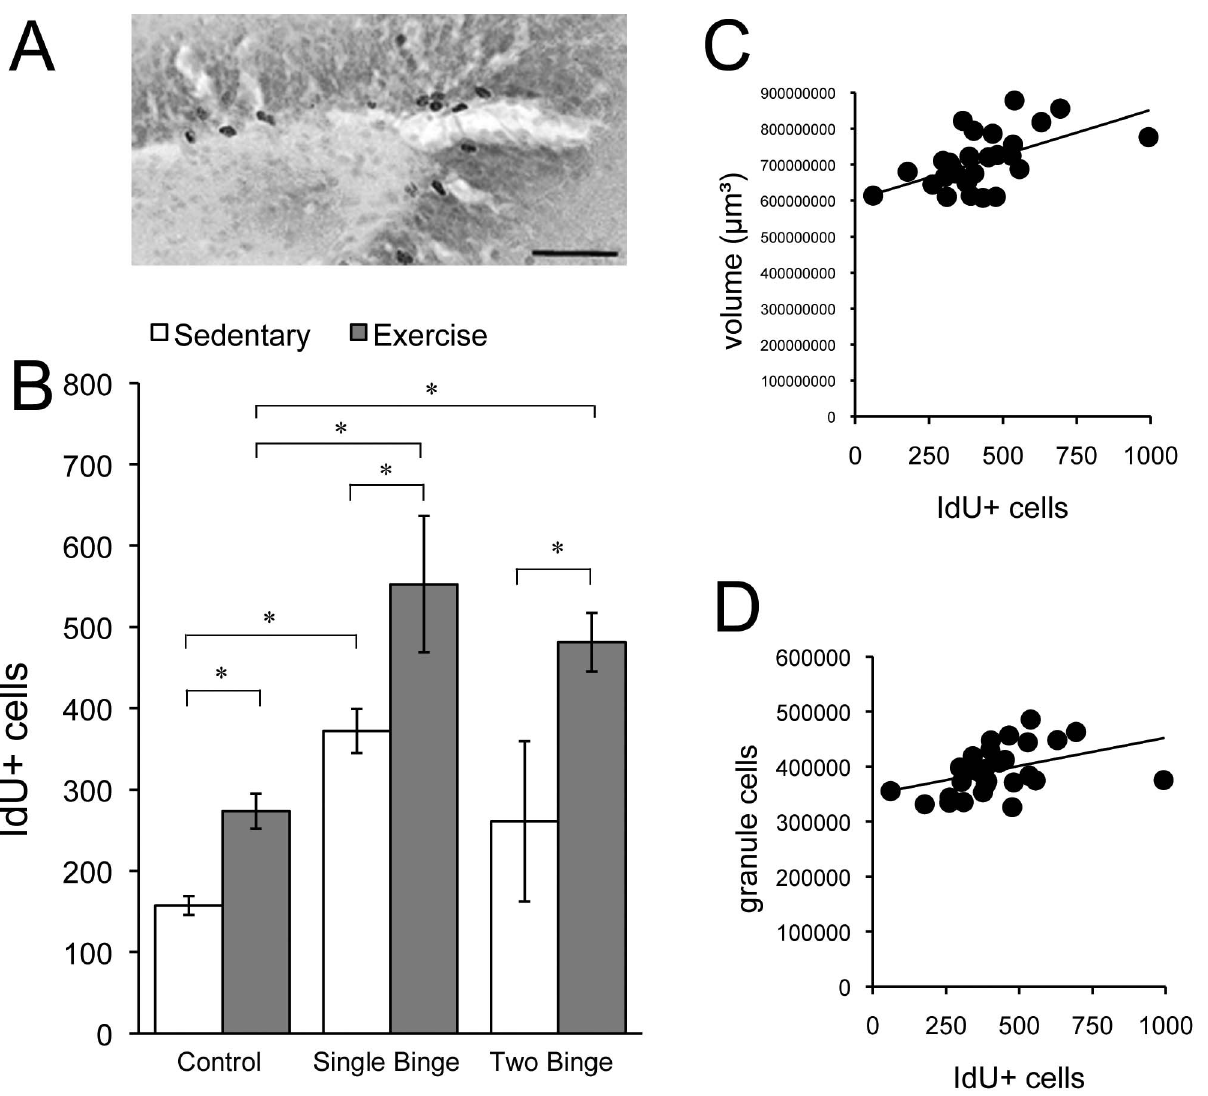
Figure 4. Exercise enhanced survival of cells generated post-binge. Sedentary single Binge animals had significantly more IdU + cells (A; scale bar=100 m m) 35 days post-binge (B). Sedentary Two Binge animals showed a non-significant increase. In all groups, exercise significantly increased the number of IdU + cells. Within binged animals, there was a significant positive correlation between number of IdU + cells and volume of the DG (C) and between number of IdU + cells and number of granule neurons (D). * p , 0.05